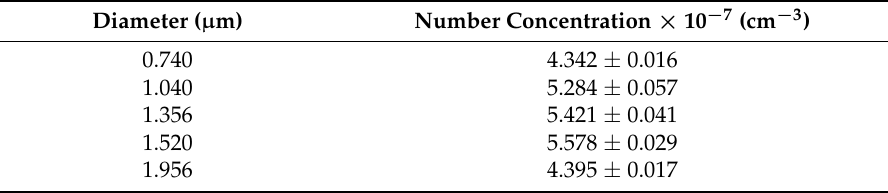
Table 1. Diameters and number concentrations of polystyrene latex